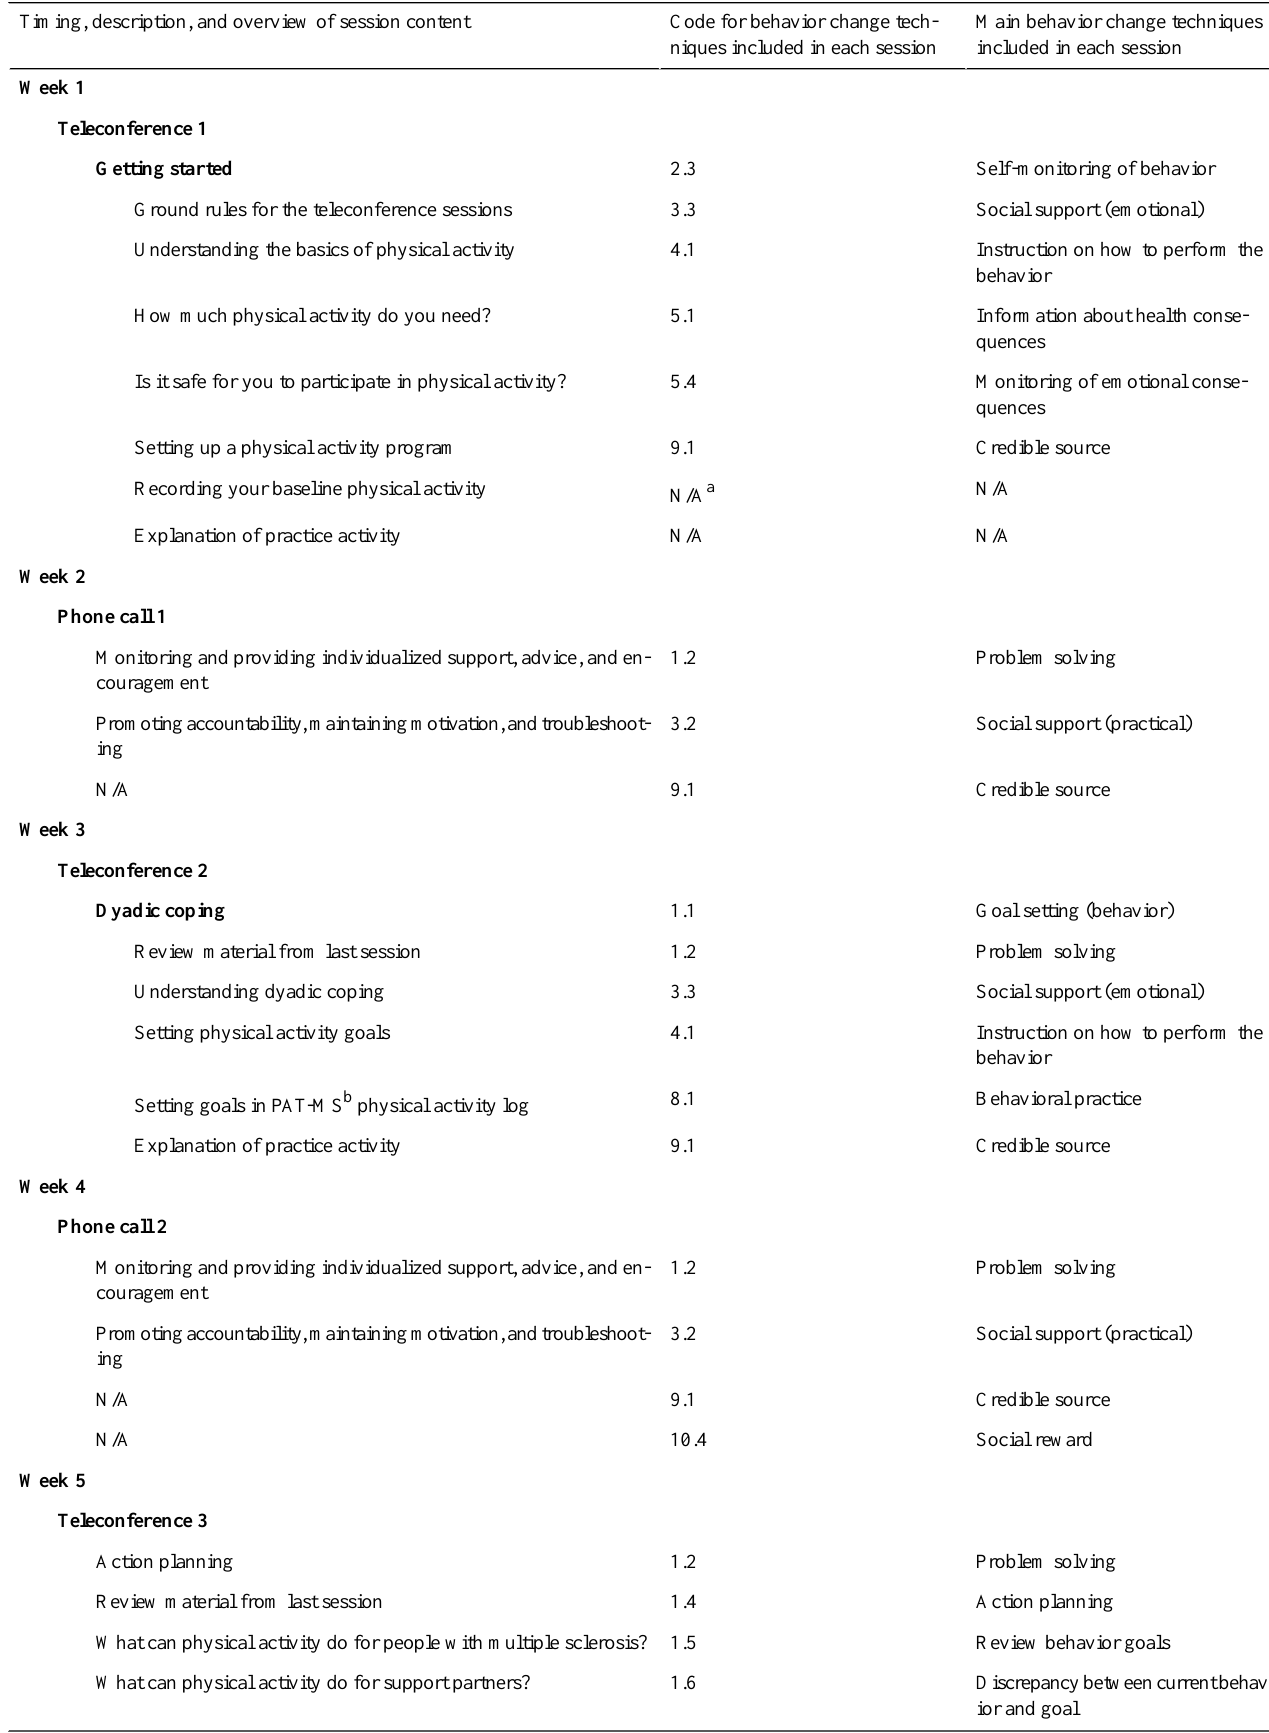
Table 1. Timing, content, and main behavior change techniques in Physical Activity Together for People With Multiple